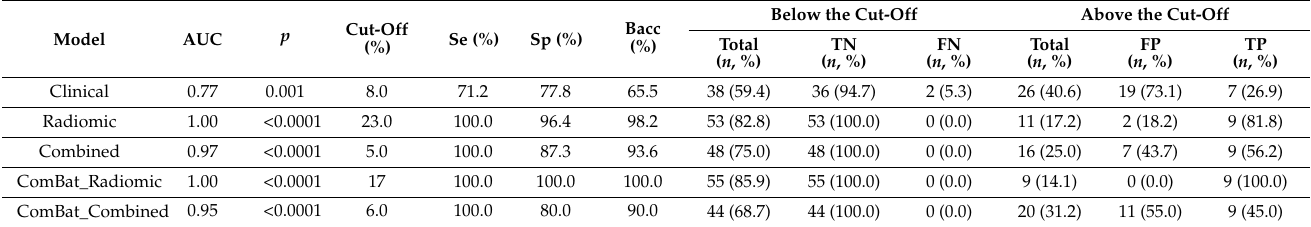
Table 2. Results of each model in the training cohort (institution 1).